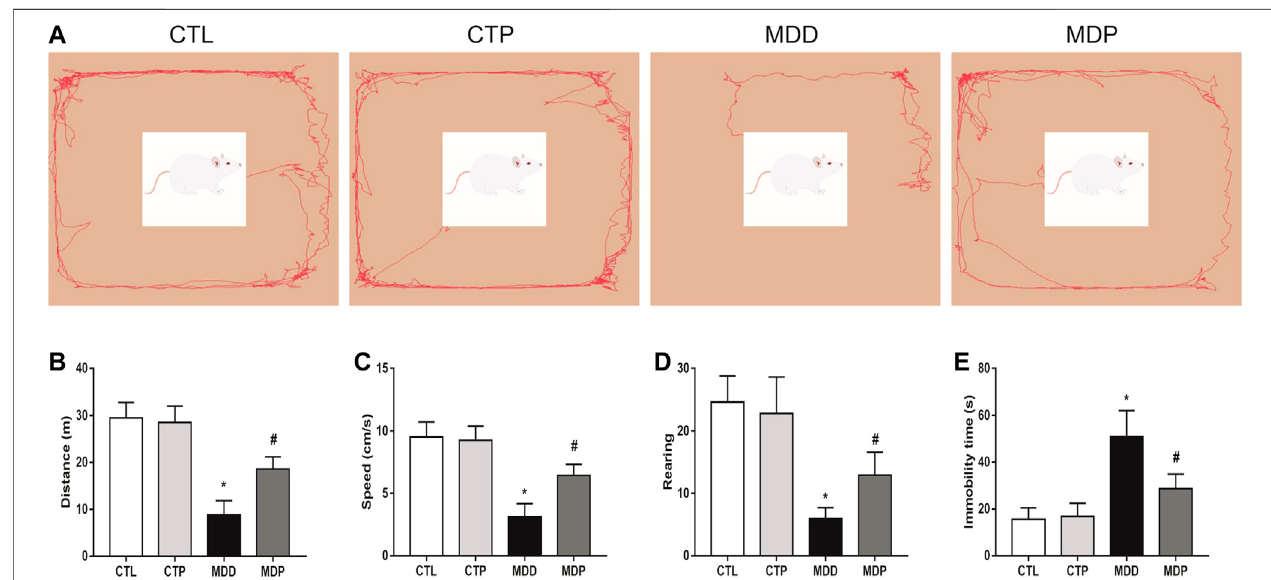
FIGURE2| Behavioraltests. (A) Representativeimages ofmovement locusinOFT. (B – D) Travelingdistance,speed, and scoreofrearing inOFT,respectively. n (cid:1) 24 per group. (E) Immobility time in FST. n (cid:1) 24 per group. * p < 0.01 vs. CTL; # p < 0.01 vs. MDD. OFT, open fi eld test; FST, forced swimming test.